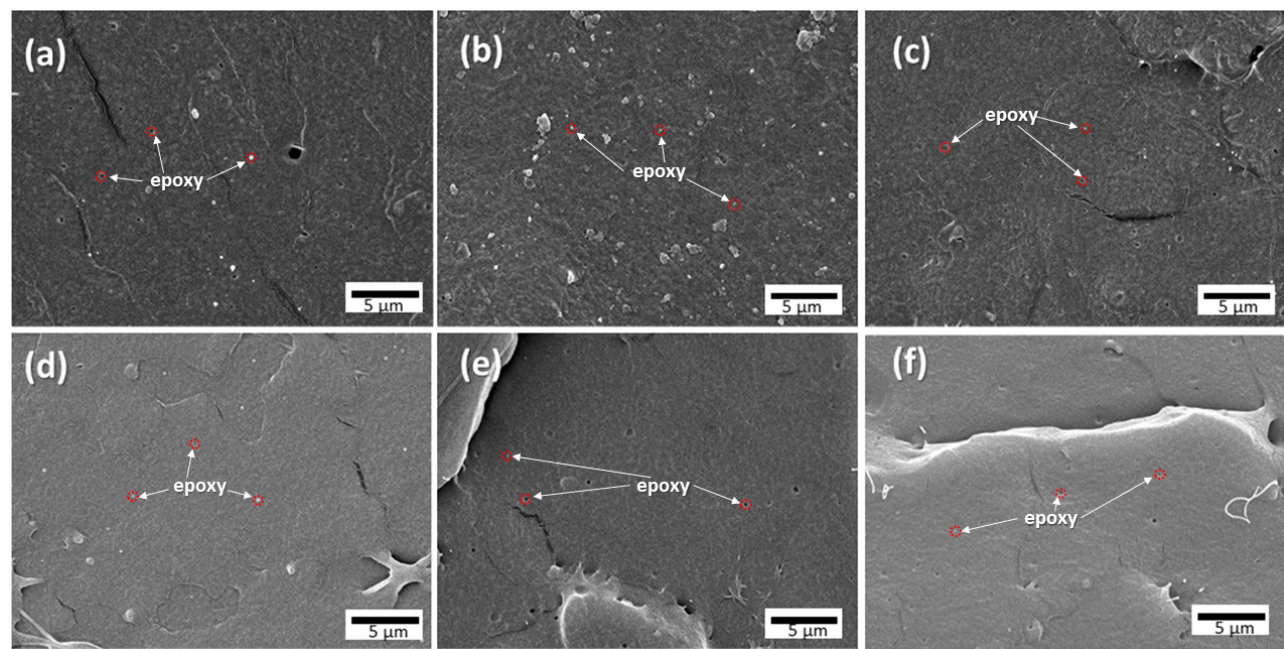
Figure 2. SEM fracture surface images of ( a ) PLA/epoxy0.5, ( b ) PLA/epoxy1, ( c ) PLA/Epoxy2, ( d ) PLA/epoxy5, ( e ) PLA/Epoxy10, and ( f ) PLA/Epoxy20.